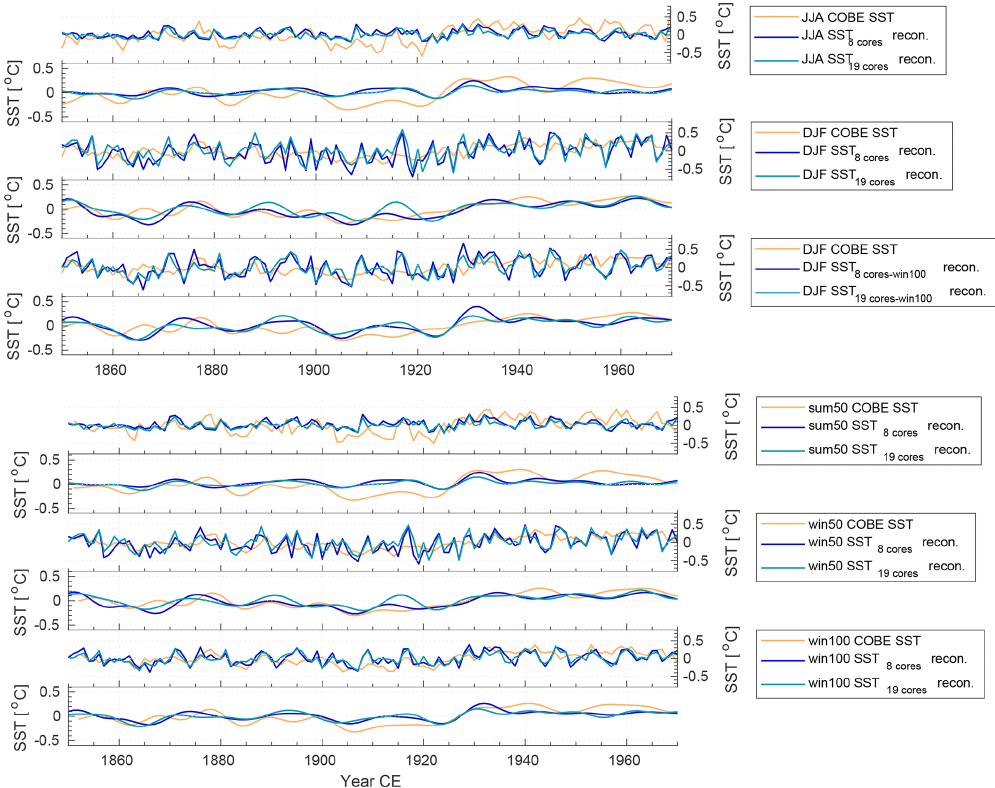
Figure 9. Time series of the North Atlantic SST index (50–70 ◦ N, 70–0 ◦ W) for reconstructions using eight ice cores (dark blue) and 19 ice cores (light blue) compared to COBE SSTs (yellow). Smoothed curves are using a decadal FFT filter. The top six plots are for JJA, DJF and DJF reconstructed using the winter-centered annual mean, while the bottom six plots are for sum50 (May–October), win50 (November–April) and the winter-centered annual mean win100